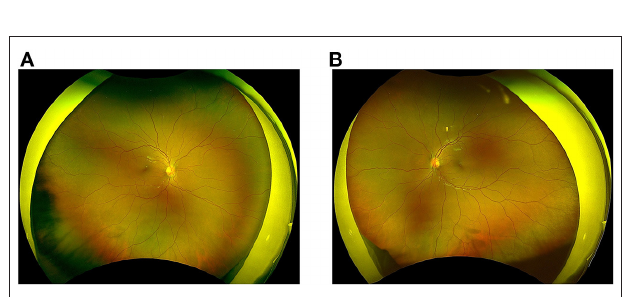
FIGURE 2 | Fundus findings before the IVIG treatment. Right (A) and left (B) wide-field fundus photographs show no abnormal